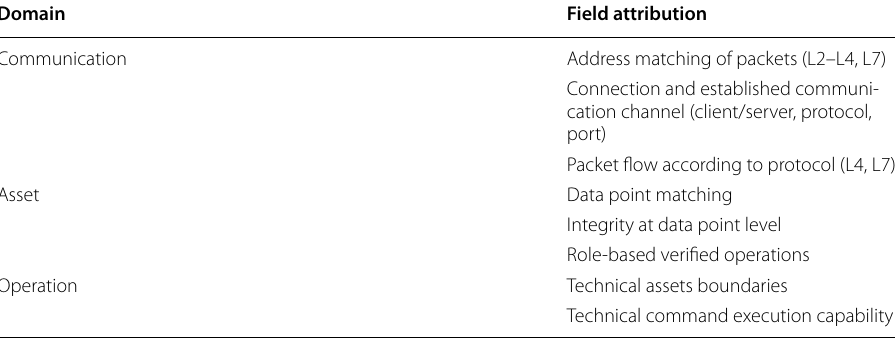
Table 1 Domain-specific attribution of captured traffic